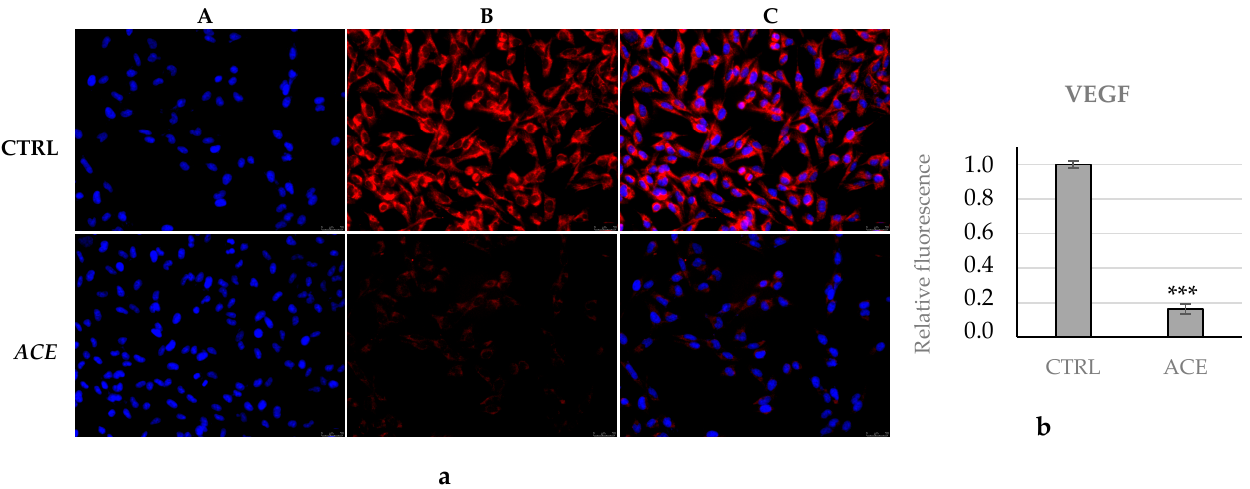
Figure 6. Immunofluorescence analysis of VEGF. ( a ) A2058 cells were treated with ethanolic A. cherimola Mill. leaf extracts (ACE) at its IC 50 value or with vehicle (DMSO, CTRL) . ACE exposure reduced VEGF expression in A2058 cells. Images were acquired at 20 × magnification. ( A ) DAPI ( λ ex/em = 350/460 nm); ( B ) Alexa Fluor ® 568 ( λ ex/em = 644/665 nm); ( C ) overlay channel. Images are representative fields of three independent experiments. ( b ) Fluorescence quantification was obtained using ImageJ. *** p < 0.001, ACE vs.